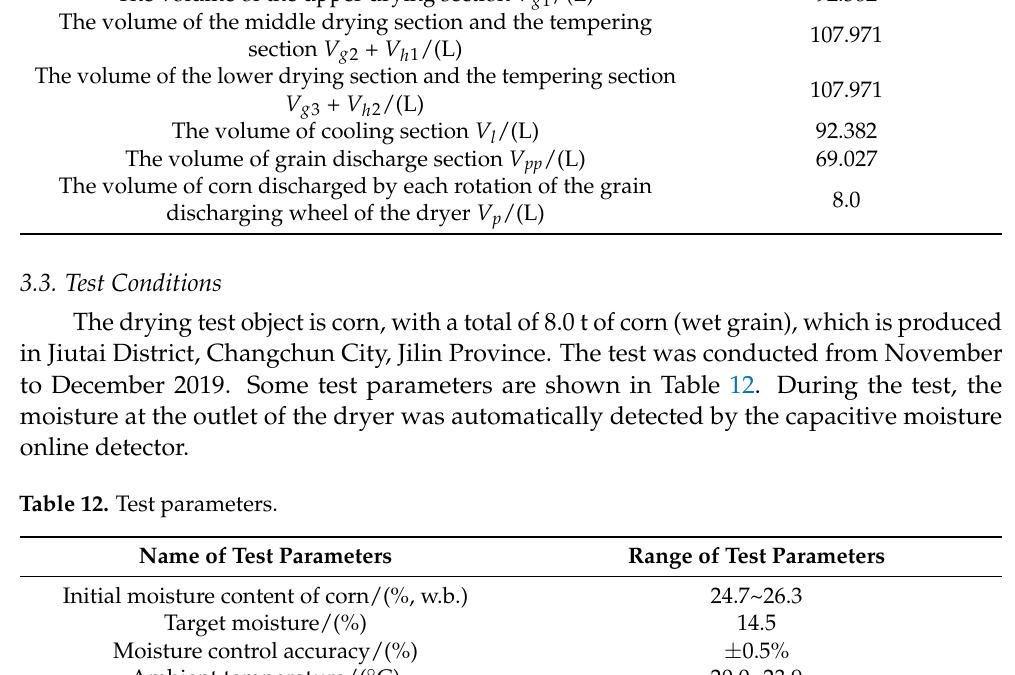
Initial moisture content of corn/(%,